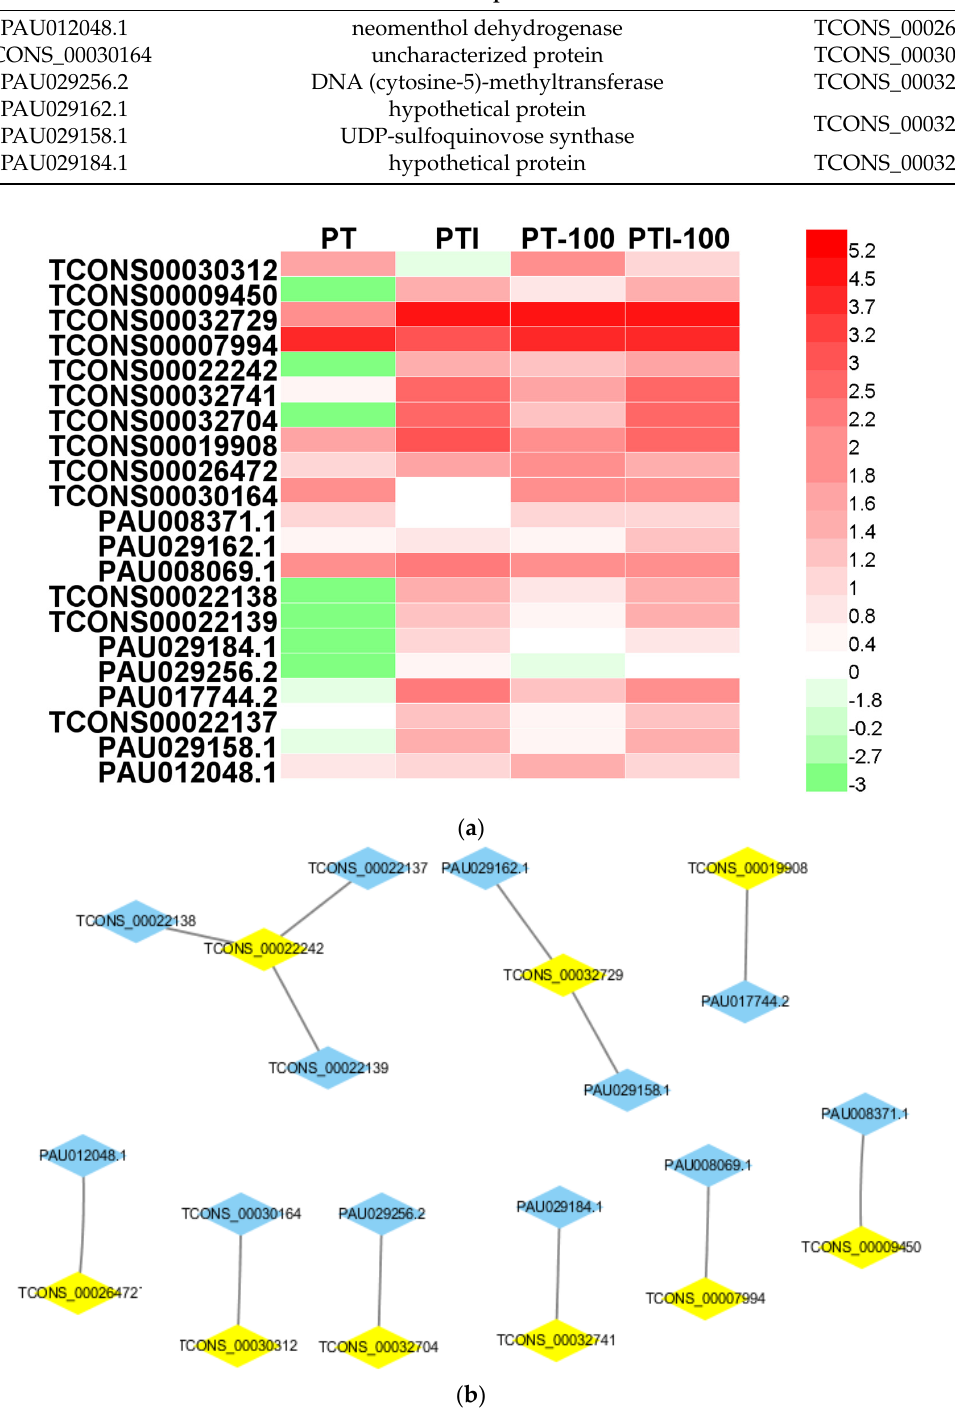
Figure 4. Characteristics of PaWB-related lncRNAs and mRNAs. ( a ) Expression profiling in PT, PTI PT-100, and PTI-100. The data were based on lg(FPKM); ( b ) LncRNA-mRNA networks. The blue polygons represent mRNAs, the yellow polygons represent lncRNAs. FPKM, fragments per kilobase of exon model per million mapped reads.